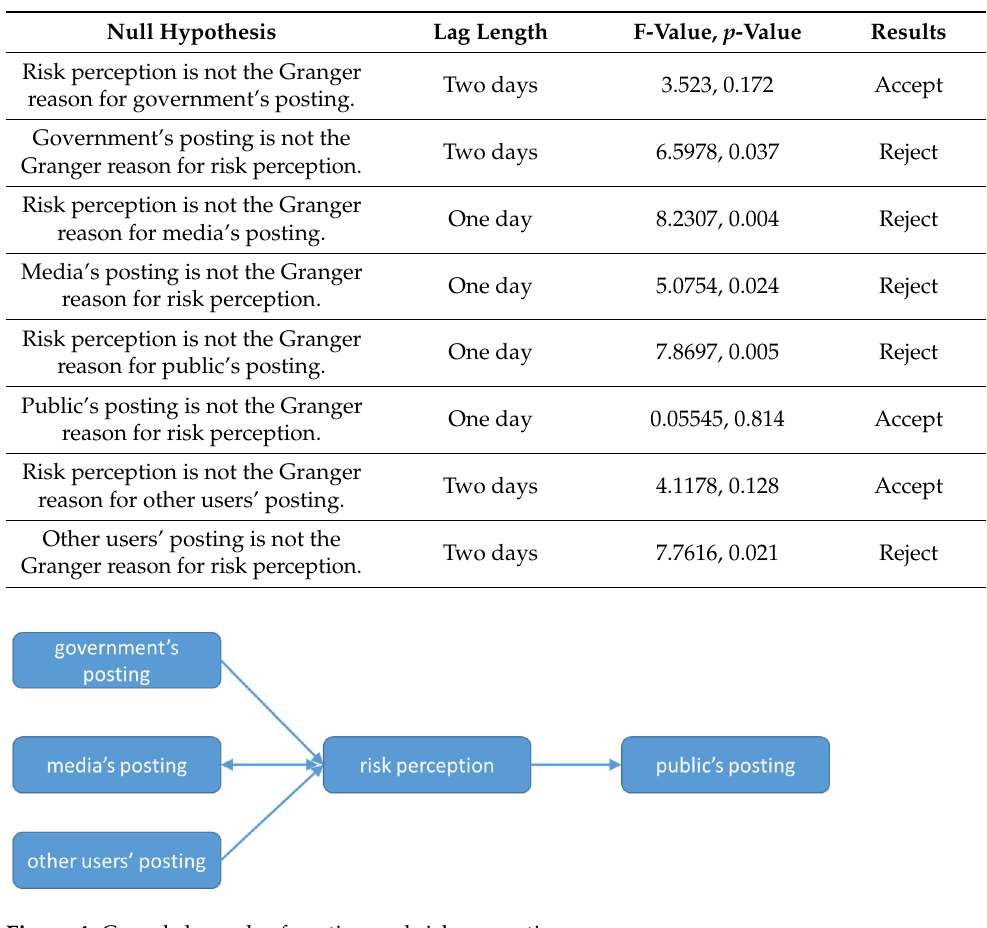
Figure 4. Causal channels of posting and risk perception.